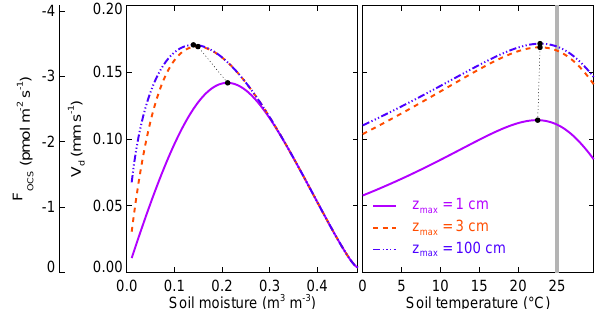
Figure 3. Sensitivity of the modelled OCS flux ( F OCS ) and depo- sition velocity ( V d ) to the formulation used to describe gaseous and solute diffusion. The soil moisture and temperature response curves shown here were obtained assuming no source term, a soil depth and pH of 1m and 7.2 respectively and a CA enhancement factor for OCS hydrolysis of 30000. Closed circles indicate the tempera- ture or soil moisture optimum of each response curve and the grey thick line in the right panel indicates the set optimal temperature for CA activity (25 ◦ C in this case).